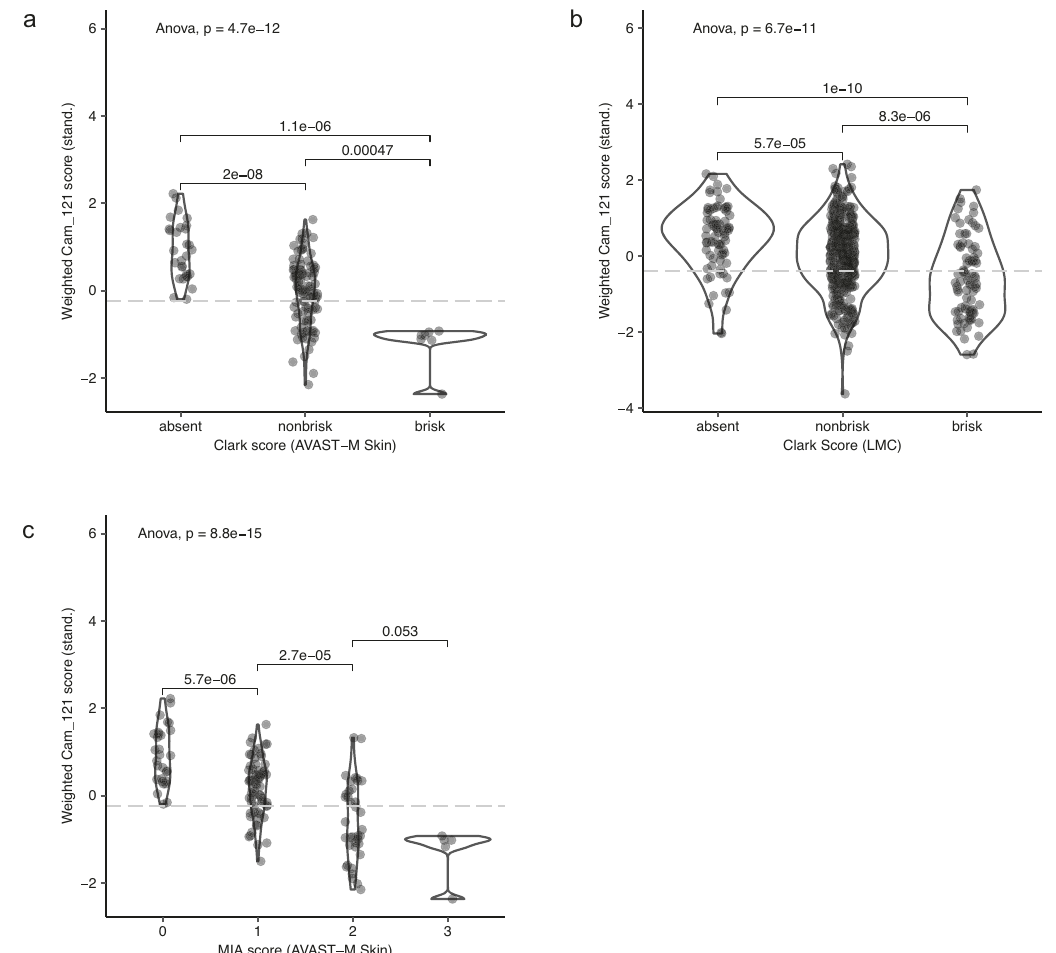
Fig. 5 Cam_121 negatively correlates with tumour-in fi ltrating lymphocyte counts. Violin plots showing the weighted (standardised) Cam_121 scores ( y - axis) by levels of the TIL scores (x-axes) in the a AVAST-M primary melanoma dataset ( n = 137) using Clark et al. 26 TIL scores, b Leeds Melanoma Cohort dataset ( n = 499) using Clark et al. TIL scores and c AVAST-M primary melanoma dataset ( n = 139) using MIA 27 TIL scores. The overall p values per plot are calculated using Fisher ’ s ANOVA, and pairwise comparison p values were de fi ned using two-sided Student ’ s t test. The grey dotted line represents the 33% quantile cut off for the gene expression signature in each dataset. Source data are provided within the Source data fi